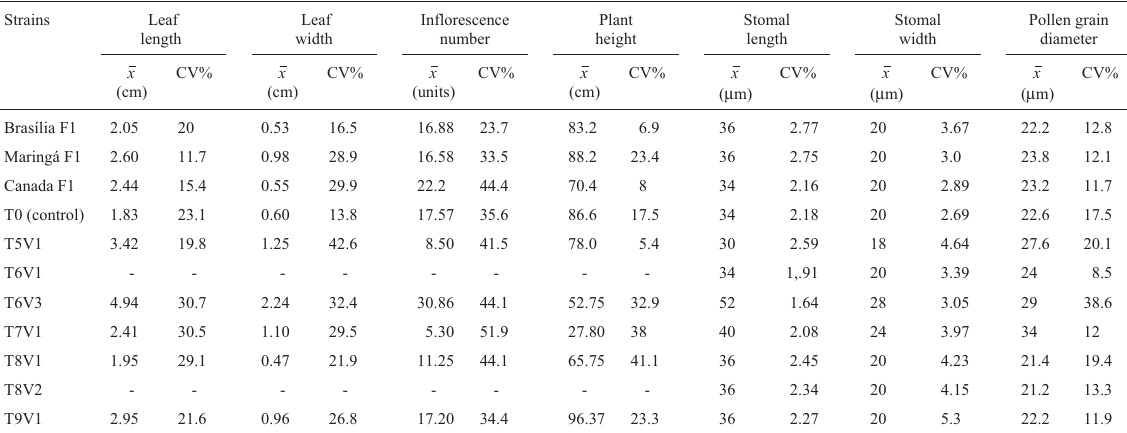
Table2 -Means( x )andcoefficientsofvariation(CV%)forplantheight,leaflengthandwidth(incm),inflorescencenumber(inunits),stomallengthand width, and pollen grain diameter (in µ m) in strains of Stevia rebaudiana (Bertoni) Bertoni grown at CPQBA/UNICAMP. Strains Leaf Leaf Inflorescence Plant Stomal Stomal length width number height length